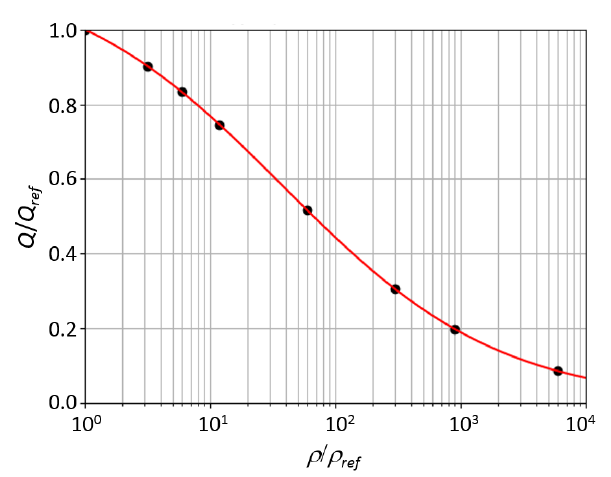
Figure 21. CST Eigenmode simulation of the Q factor variation versus resistivity, normalized to copper.